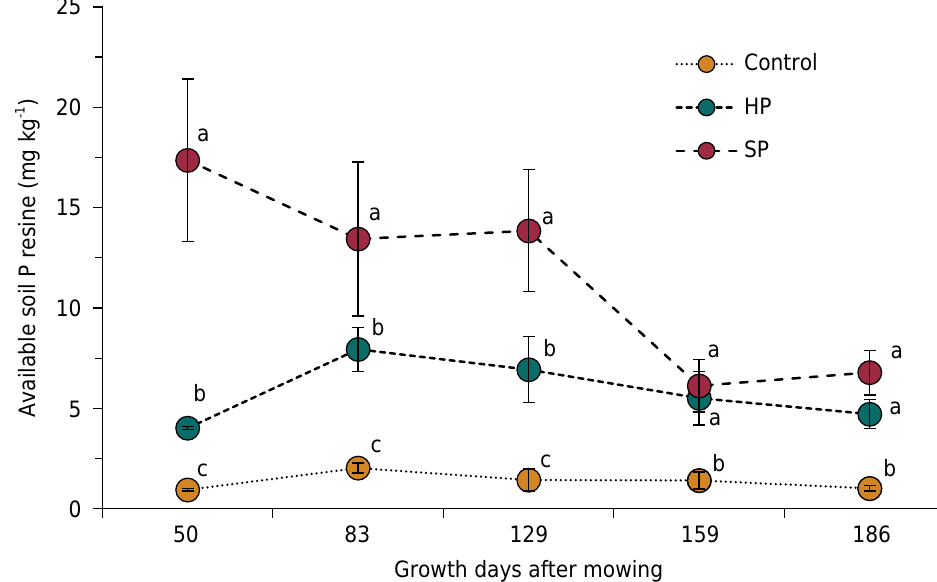
Figure 1. Soil available P over time in a natural grassland, from Southern Brazil, affected by the application of different P sources. Control: without P addition; HP: hyperphosphate; and SP: